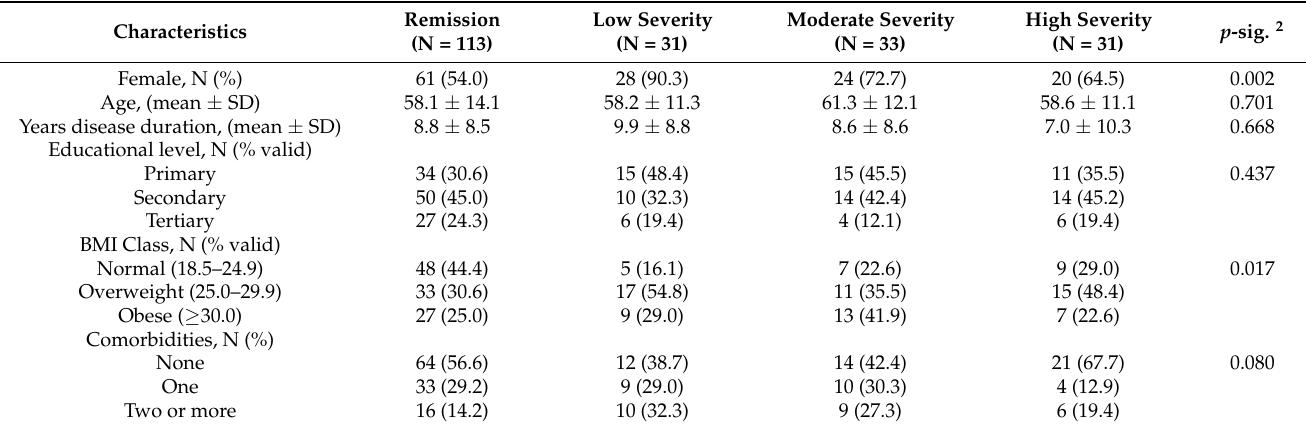
Table 2. Demographic and clinical characteristics of the sample by disease severity 1